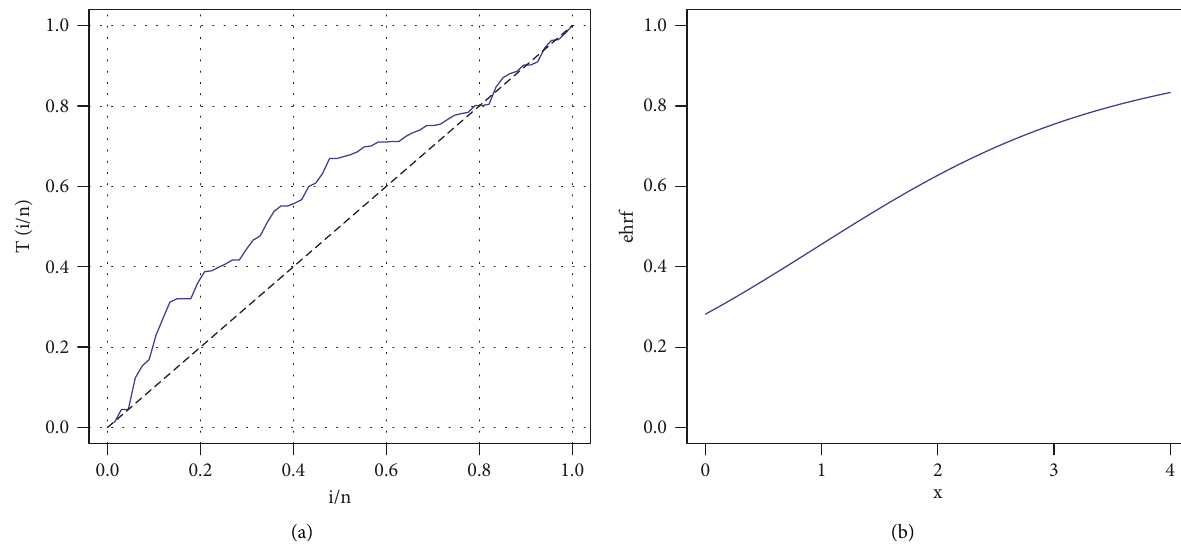
Figure 3: (a) TTT plot and (b) estimated